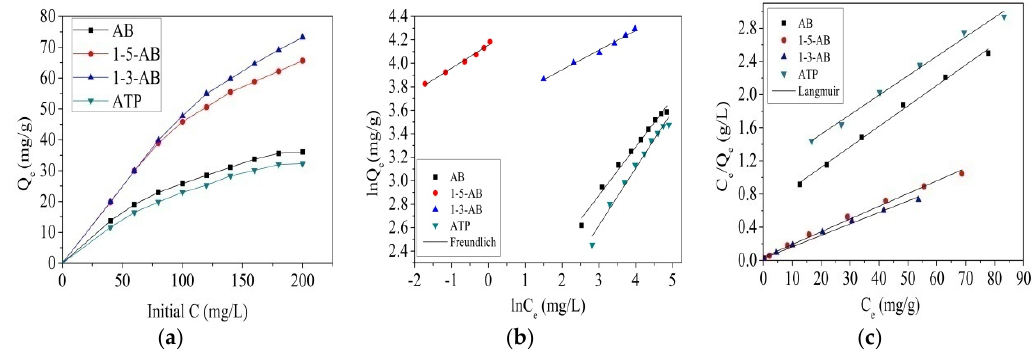
Figure 6. Sorption isotherms of RBR on the biochar samples: ( a ) initial concentration vs. sorption capacity of the three biochar samples for RBR, ( b ) Freundlich isotherm parameter, and ( c ) Langmuir isotherm parameter (dosage, 0.1 g; temperature, 25 °C; initial concentration, 40–200 mg/L; initial pH, 6.0–7.0).